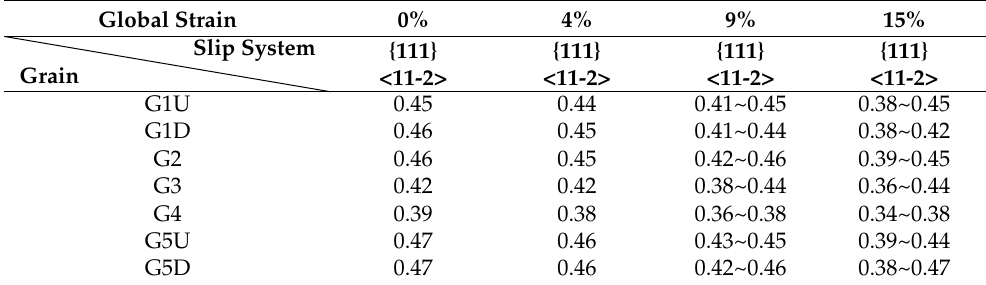
Table 2. The Schmid factors for several abnormal grains in Figure 8 at different global strains. Global Strain 0% 4% 9% 15% Slip System {111} {111} {111} {111} Grain <11-2> <11-2> <11-2>